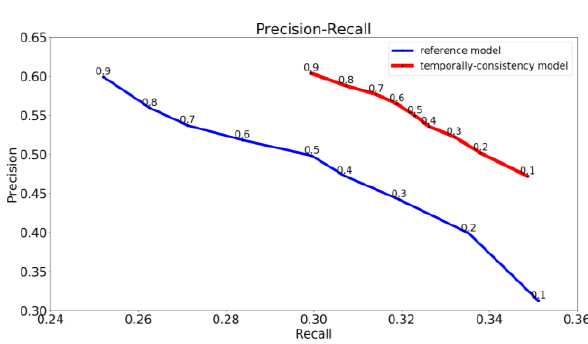
Figure 2 Precision-recall graphs of two models The areas of rectangle of each model on every score threshold can be seen in Error! Reference source not found. . The highlights are the maximum value of precision and recall products of each model. The corresponding score is considered as the “best” score threshold. By comparing the “best” results of these models, we can find that continuous later neural network is better than the other three models. The largest area of the rectangle (score threshold on 0.7 continuous later network) is 21.4 percent larger than the smallest (score threshold on 0.5 single images network).